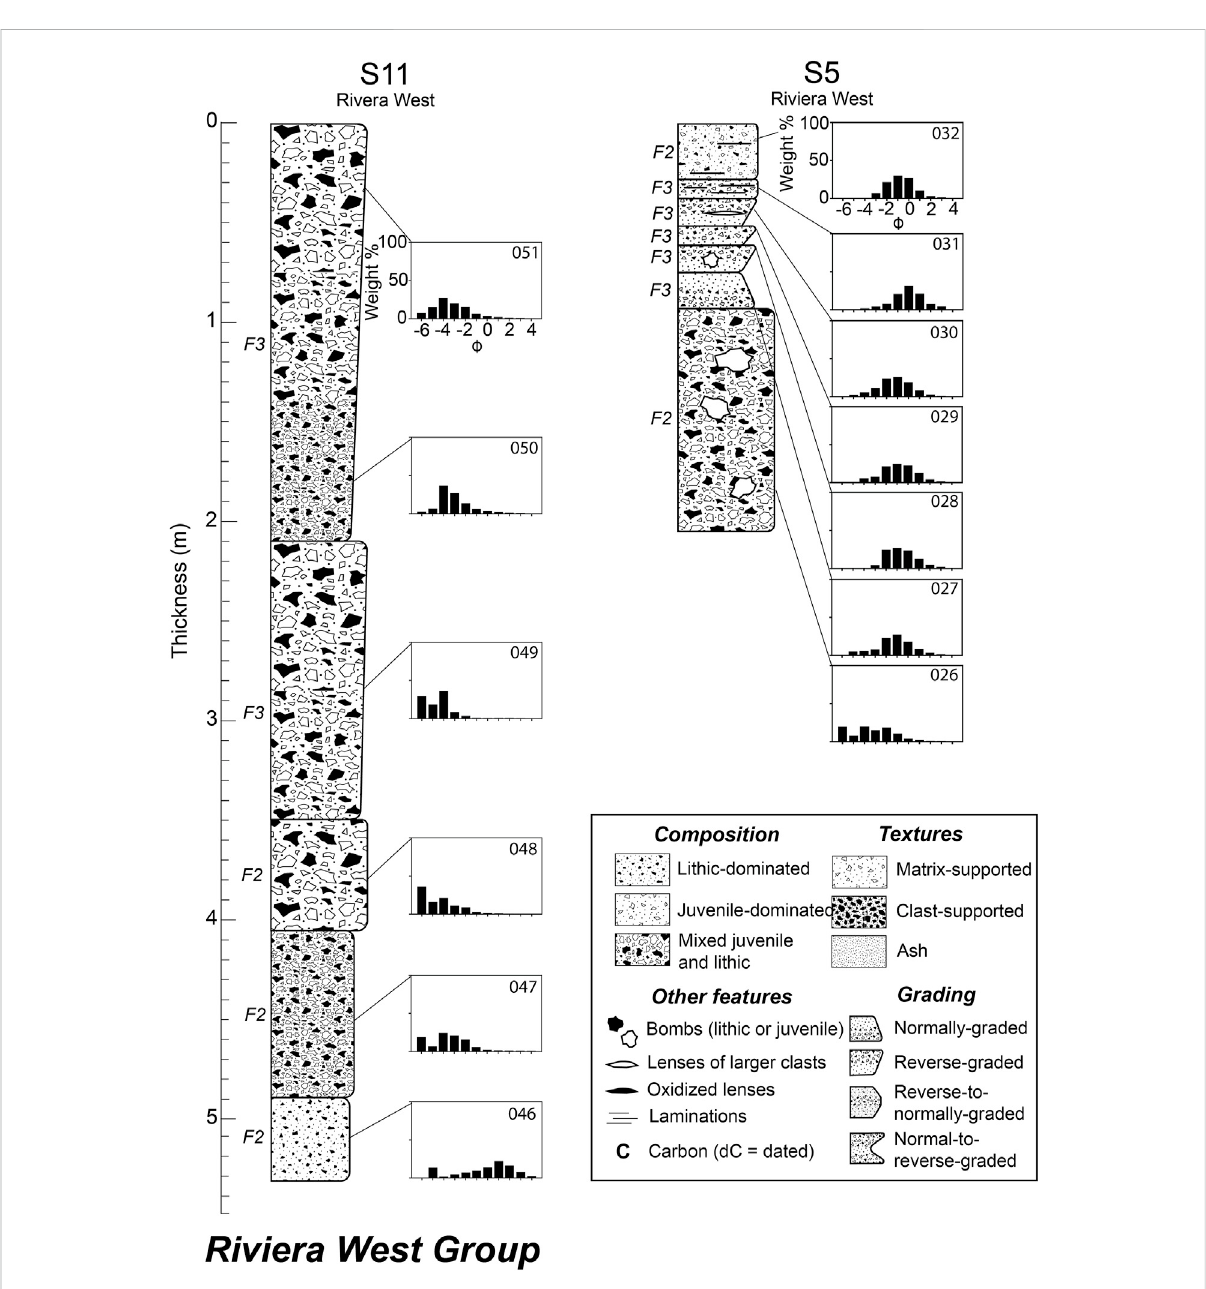
FIGURE 6 Stratigraphy of outcrops in the Riviera West housing development on the east side of the Buckingham Peninsula. See Figure 5 caption for interpretation notes. Columns are ordered according to their geographic progression from west to east; no correlations or relationships to source vents are implied by this